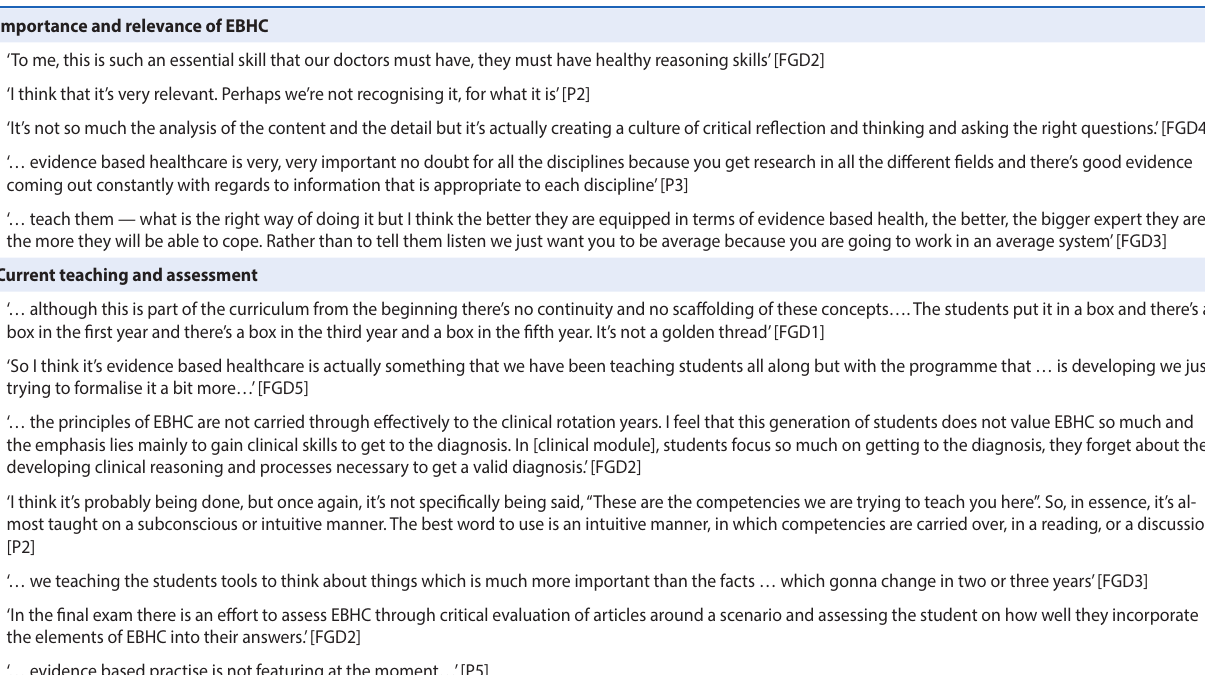
Table 1: Interviewees’ perspectives on EBHC relevance and current level of EBHC teaching Importance and relevance of